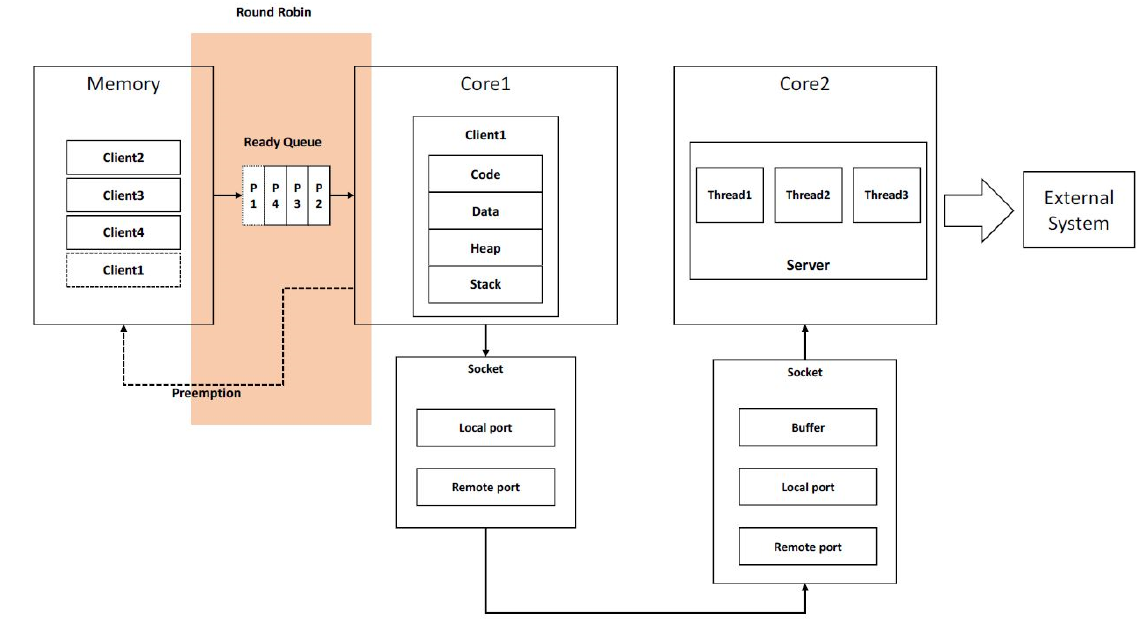
Figure 3. The proposed architecture of a fusion system.